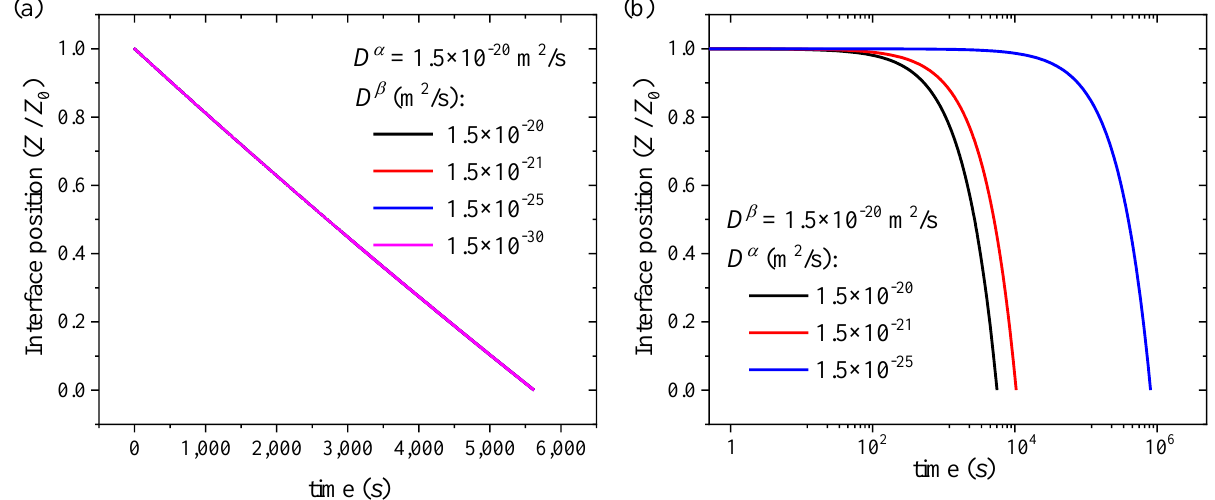
Figure A2. Temporal variation in the interface position between pure silicon ( β phase) and the Li-poor phase ( α phase) in the thin film electrode for different values of ( a ) D β (Li diffusivity in a-Si- β phase) and D α (Li diffusivity in Li 0.3 Si- α phase) =1.5 × 10 − 20 m 2 /s, and ( b ) D α and D β = 1.5 × 10 − 20 m 2 /s.